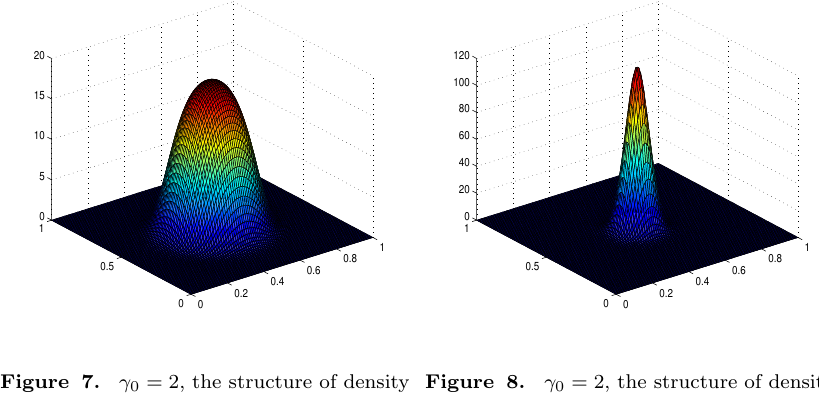
Figure 8. γ 0 = 2, the structure of density u ( x,t ) at t = 0 . 04.